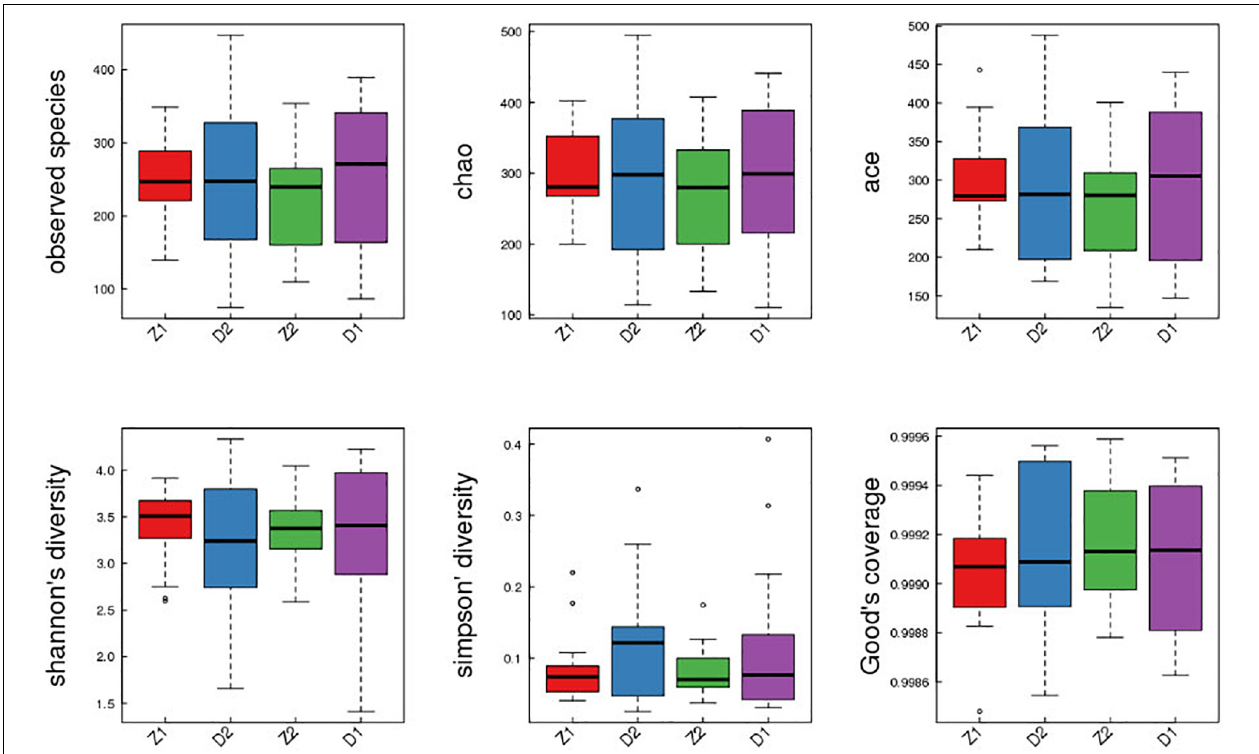
FIGURE 6 | Alpha diversity of intestinal flora in the patients in the Electroacupuncture group and the Control group (Z1, the Electroacupuncture group before treatment; Z2, the Electroacupuncture group after treatment; D1, the Control group before treatment; D2, the Control group after treatment).